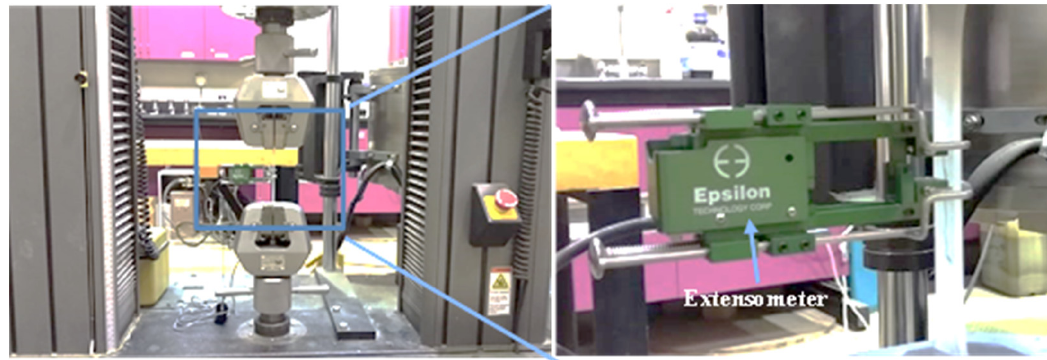
Figure 3. Tensile testing. Figure 3. Tensile